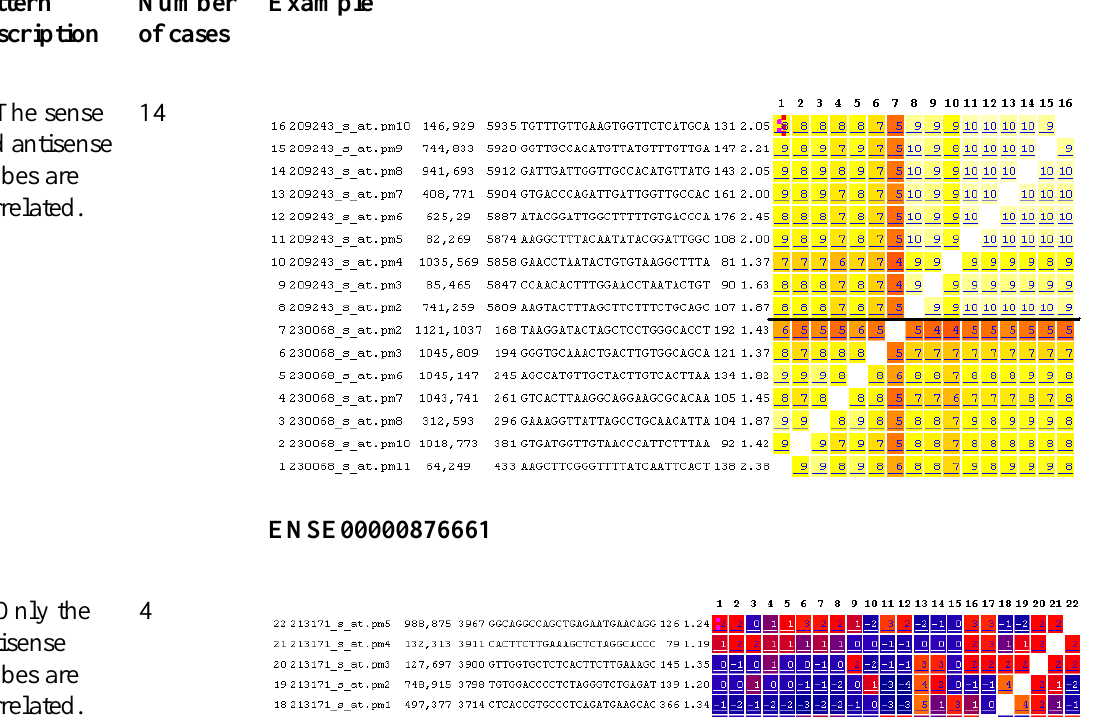
Table 1. Examples of general patterns of exons containing probes in sense and antisense directions. In each heatmap, the probes below the line align in the antisense direction and the probes above the line align in the sense direction. The antisense and sense probes do not necessarily